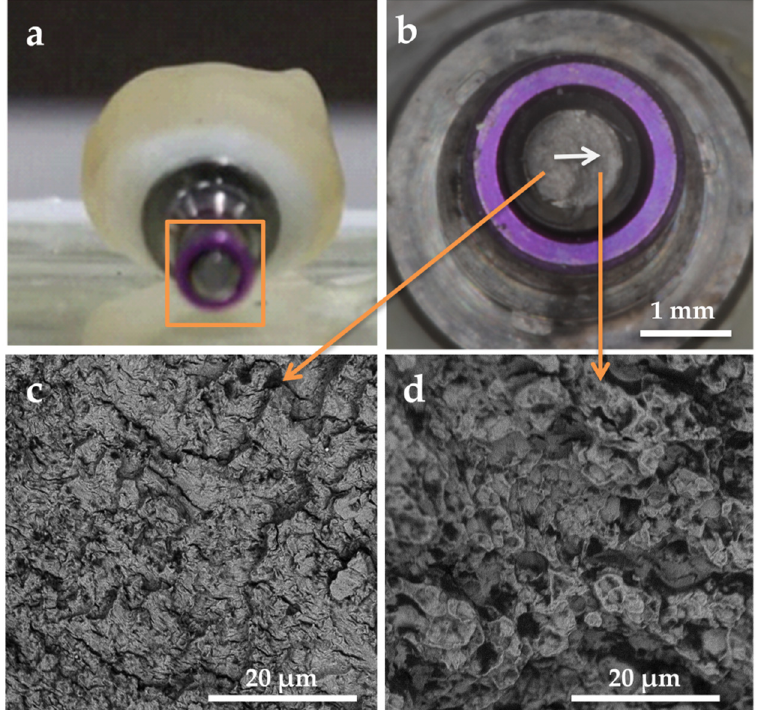
Figure 6. Representative image of the tube in tube internal connection specimen after the fatigue test showing an abutment screw fracture: ( a ) general view; ( b ) top view with an SEM analysis performed on each separate region of the fractured area: ( c ) fatigue striated zone and ( d ) catastrophic dimple zone. The white arrow shows the fracture direction of the screw.